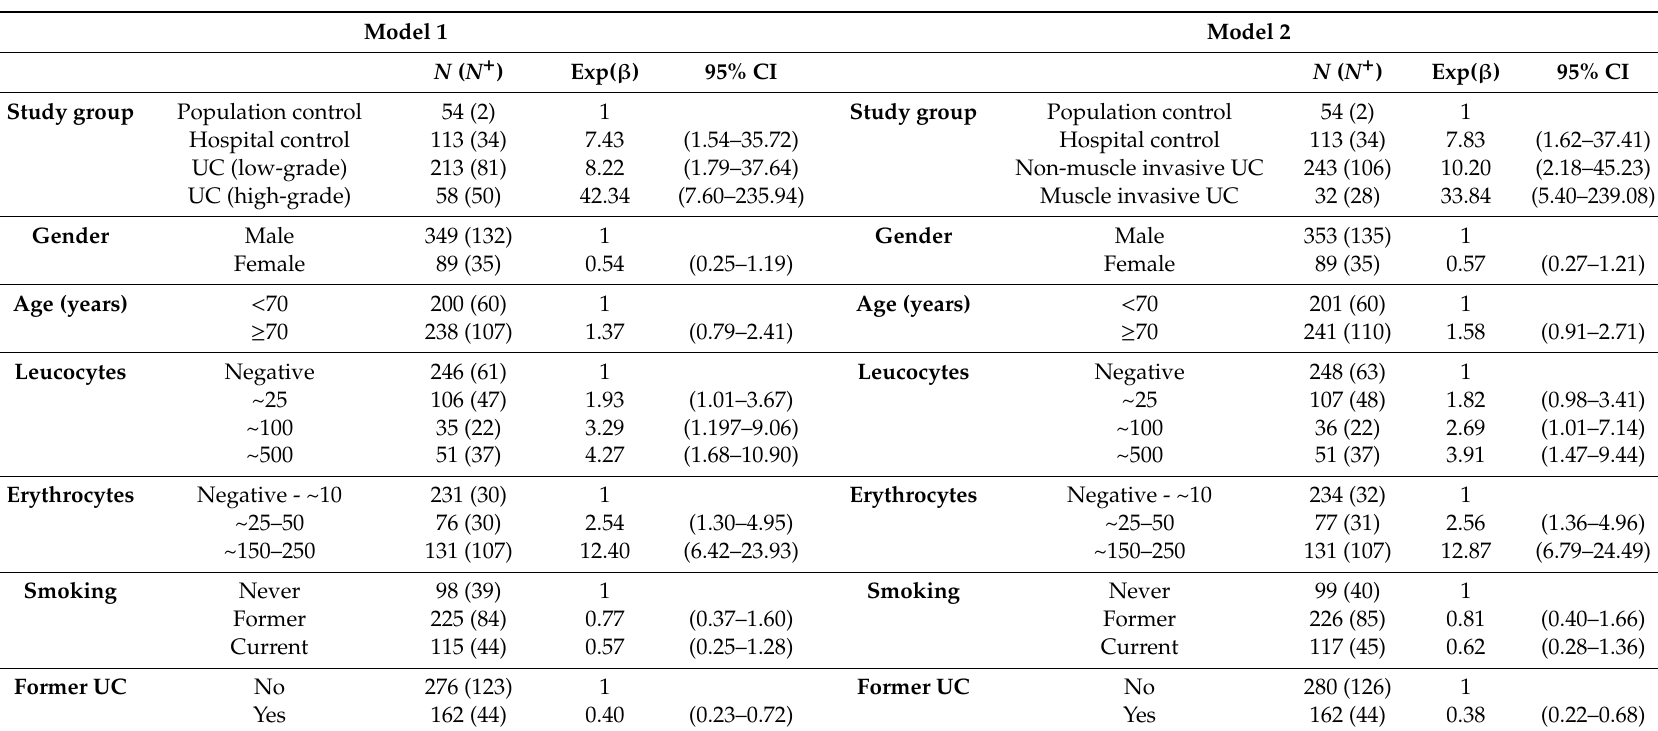
Table 2. Influence of study group and group characteristics: odds ratios with 95% confidence intervals (CIs) for having a normalized TGFBI value ≥ 1345.97 pg / mg creatinine (P95 in population controls) determined by multiple logistic regression analyses ( N + : number of participants with normalized TGFBI value ≥ 1345.97 pg / mg creatinine). Participants with missing data in one or more sample characteristics were rejected from analysis; odds ratios (Exp( β )) with the 95% confidence intervals (CI) were shown; N + : number of participants with normalized TGFBI value ≥ 1345.97 pg / mg creatinine). Model 1 and 2 di ff ered with regard to their evaluated study